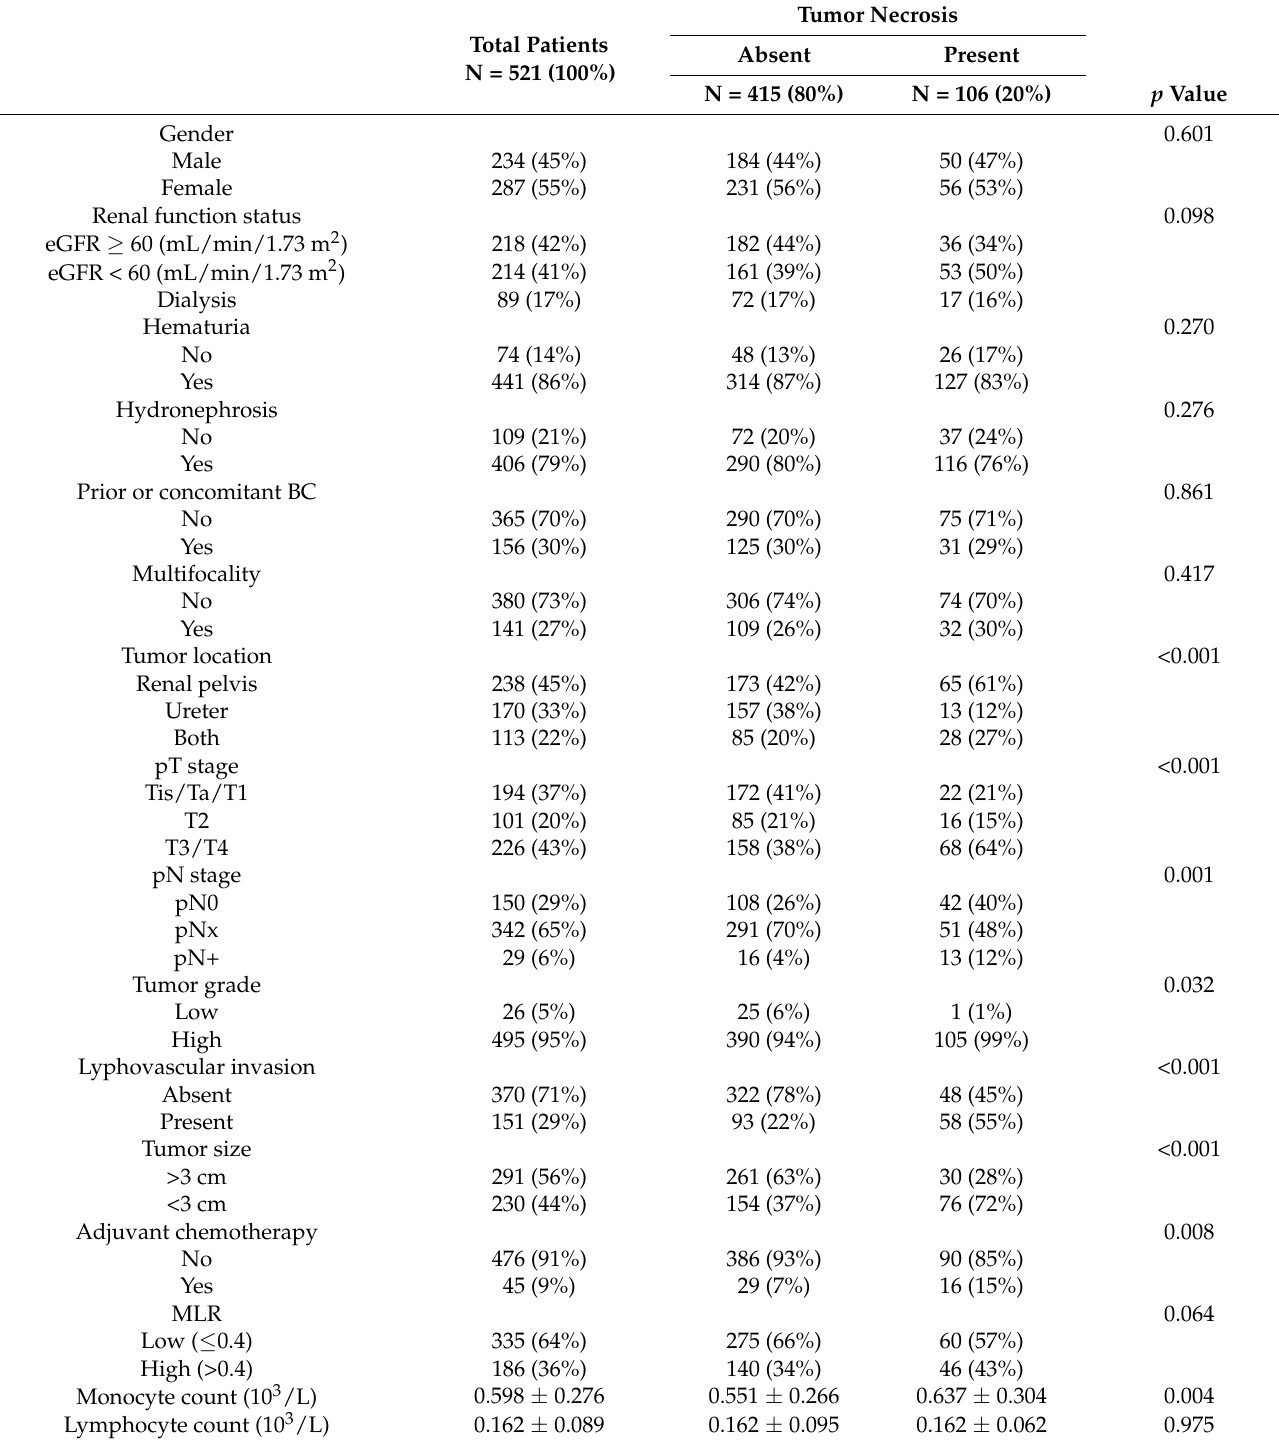
RNU = radical nephroureterectomy; eGFR = estimated glomerular filtration rate; BC = bladder cancer; MLR = monocyte-to-lymphocyte